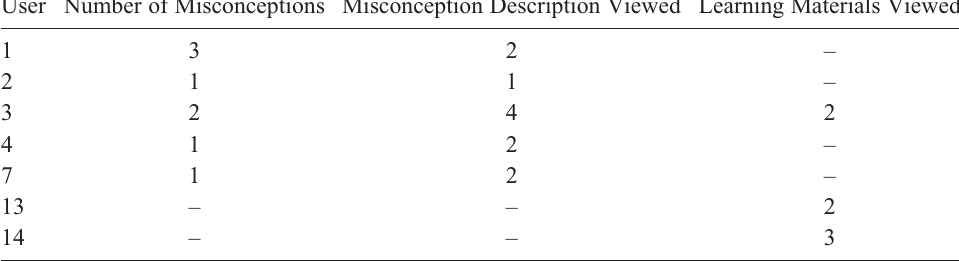
Table 2. Viewings of misconceptions and learning